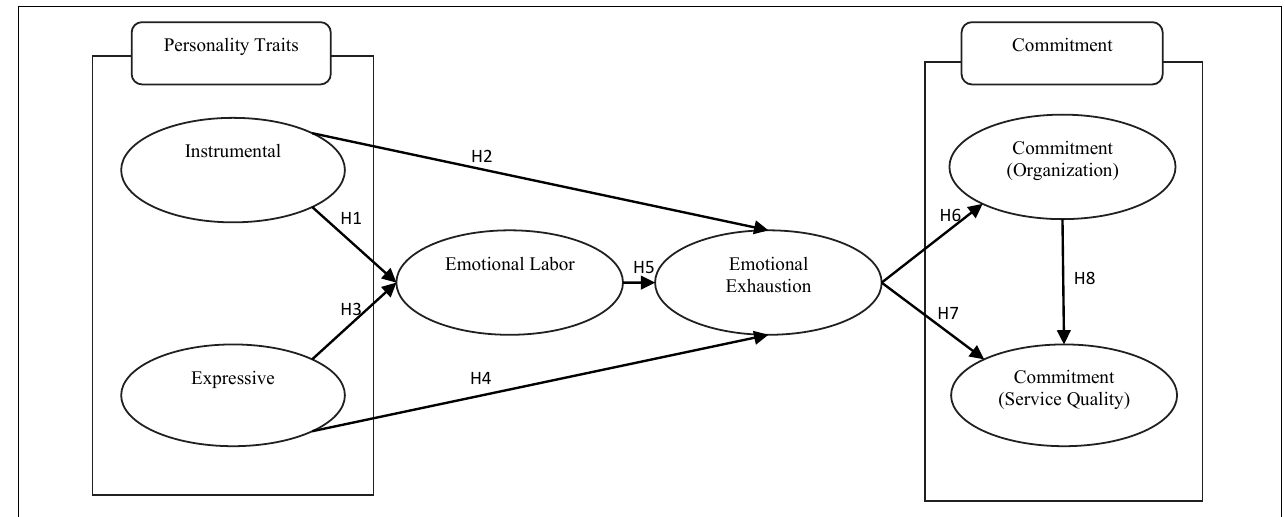
FIGURE 1 | Conceptual model of personality traits and emotional